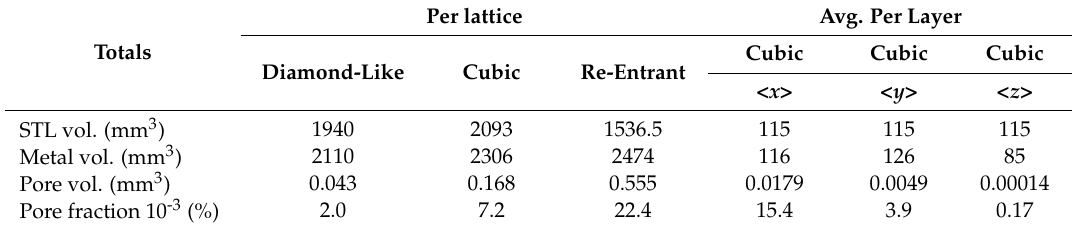
Table 2. Metal and pore volume in mm 3 of all three lattices and per layer in the three orthogonal directions excluding nodes for the cubic lattice. The standard tessellation language file (STL) volume is added for